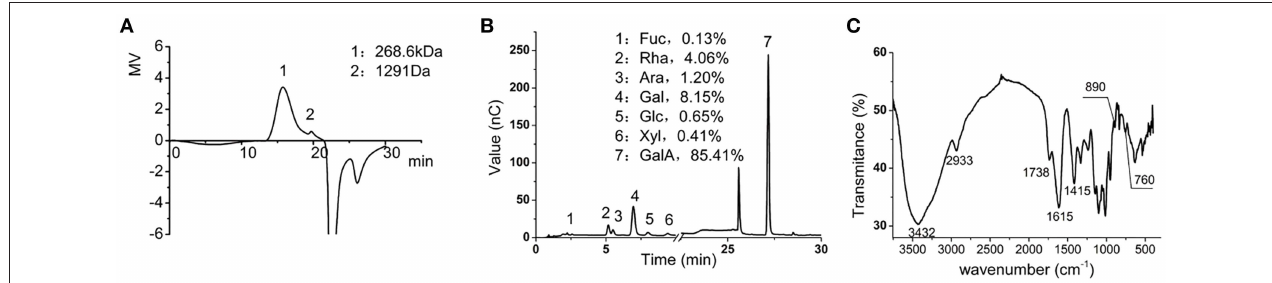
FIGURE 1 | Chemical characterization of LMP. (A) The molecular weight of LMP was determined by HPGPC. (B) Chromatographic profile was obtained by HPAEC-PAD of monosaccharides of LMP. (C) FTIR profile of LMP.